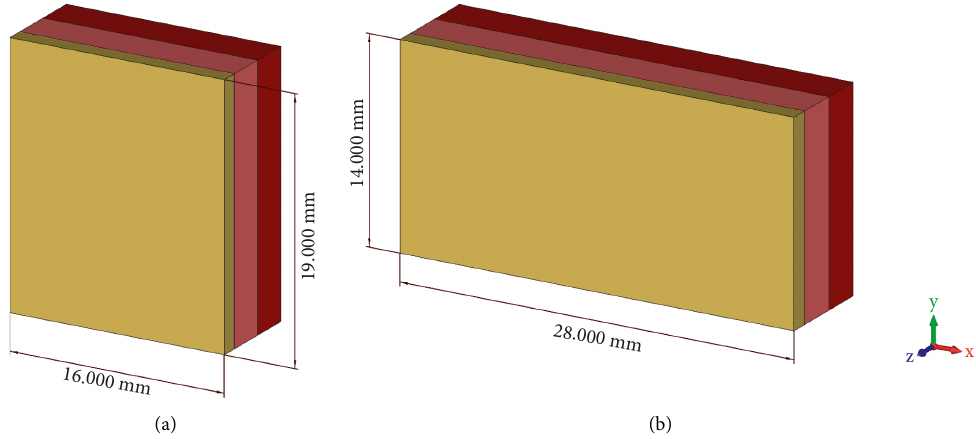
Figure 34: Human body model dimensions (a) for all arrays except 1 × 4 array and (b) for 1 × 4 array.